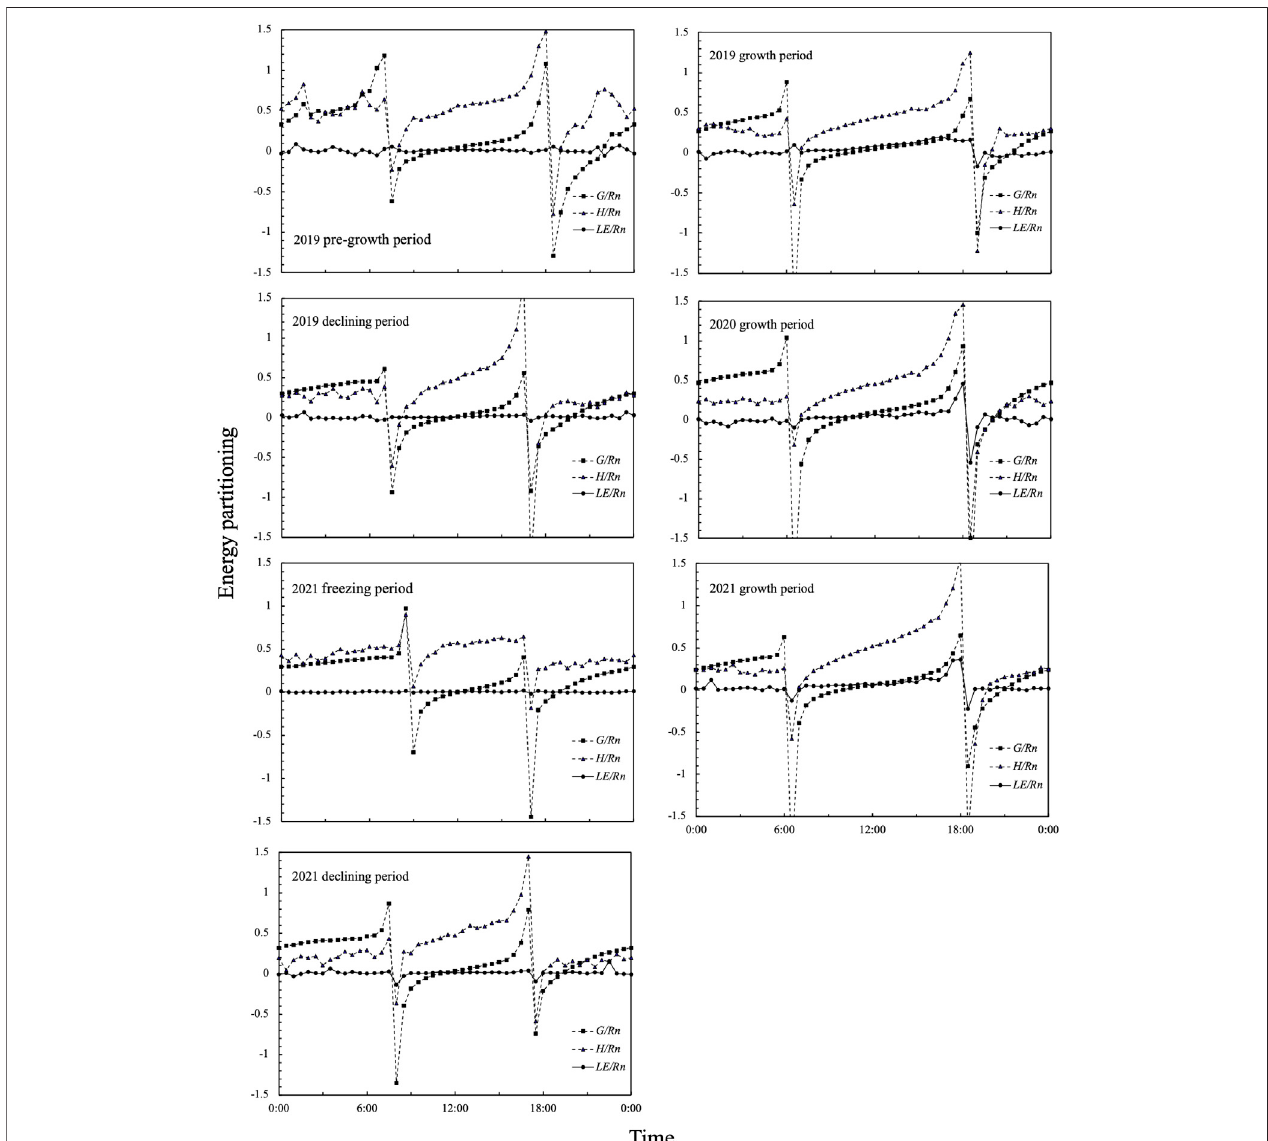
FIGURE 6 | Diurnal variation of energy distribution in the Inner Mongolian desert ecosystem during different observation periods.